Question: Condense the content of this figure into a single sentence.
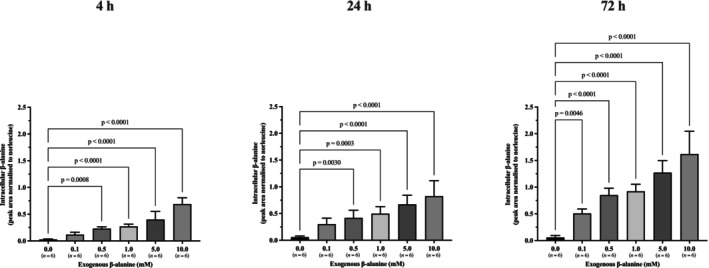
Answer: Intracellular β‐alanine in differentiated H9c2 cells after 4, 24, and 72 h of exogenous β‐alanine incubation. Data are calculated as analyte peak area normalized to the internal standard (Norleucine) peak area and presented as mean ± 1 SD. Replicate numbers included in analysis are presented underneath each respective concentration.